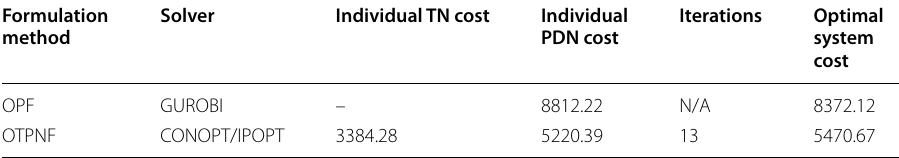
Table 2 Comparison of costs (Euro) associated with the TN and PDN Formulation